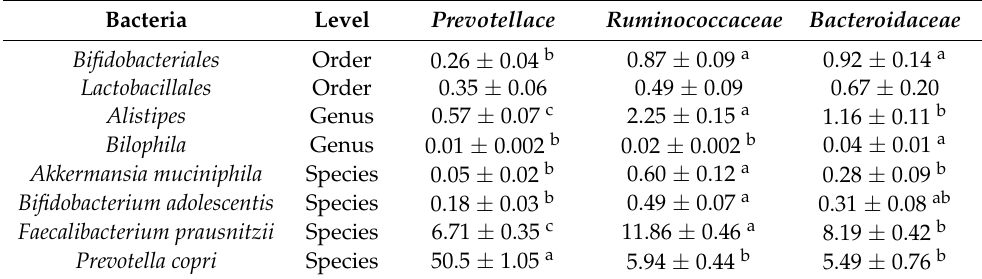
Table 3. Gut microbiomes in order and species levels (unit: %).